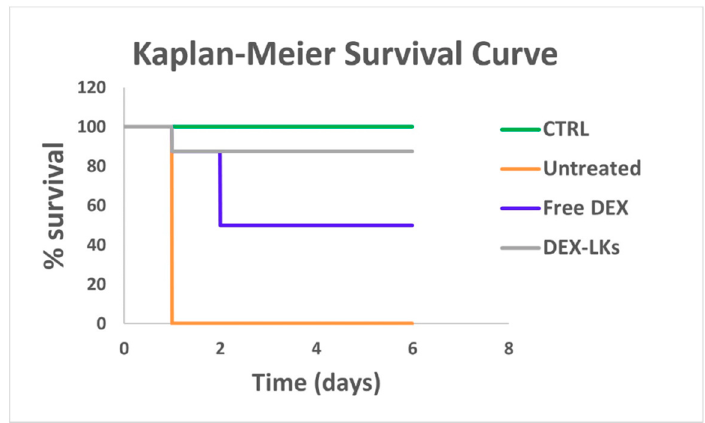
Figure 3. Leukosomes prolong the in vivo survival in an LPS-induced endotoxemia murine model. Kaplan–Meier survival curves of mice (n = 8) injected with LPS and treated with free dexamethasone (Free DEX) and dexamethasone-loaded leukosomes (DEX-LKs) or left untreated. Healthy mice were used as control (CTRL).